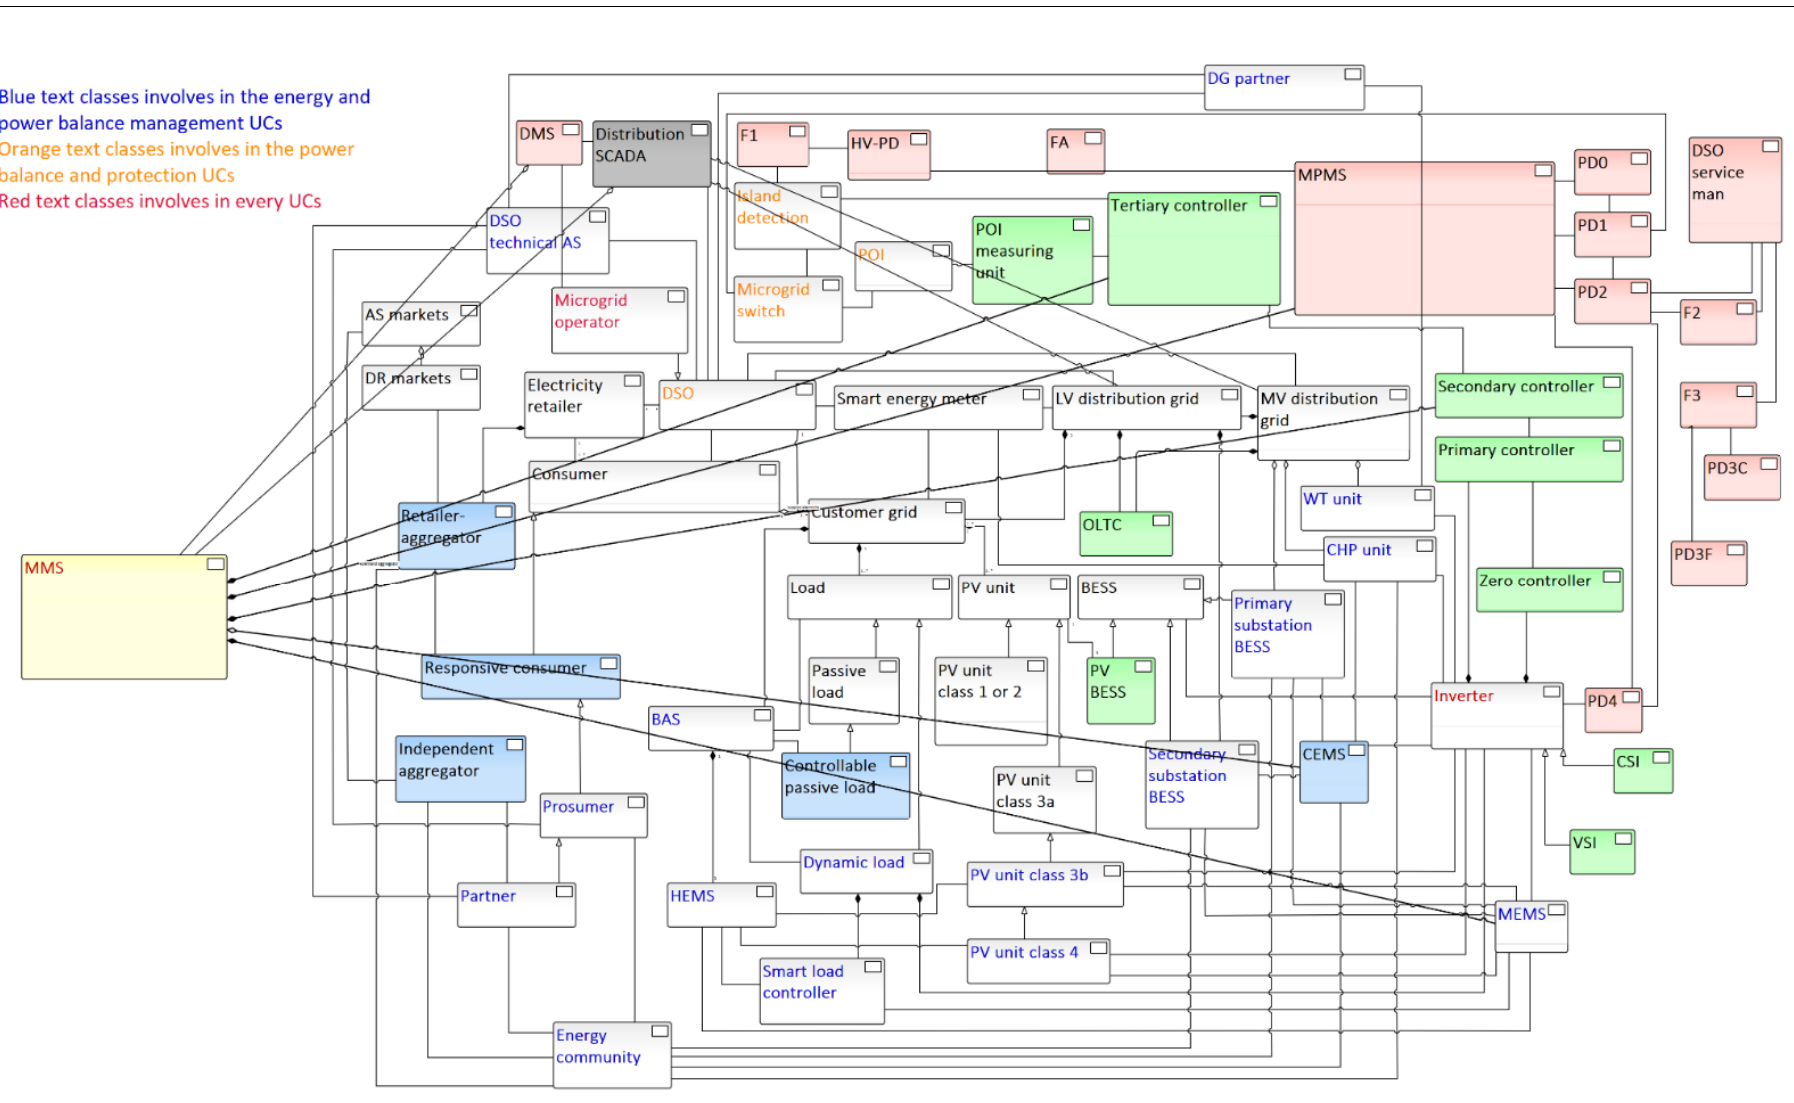
Figure 6. Class diagram of the suburban distribution network management of the microgrid phase. In the class diagrams, similar classes are combined in a more general class by gener- alization, identifying common elements of entities. Therefore, a superclass (a parent) has the most general attributes ( − ), operations (+), and relationships that can be shared with/inherits to subclasses (children). Hence, a subclass may have more specialized attrib- utes and operations. Different types of relationships between the actors are present. Ag- gregation ( ◊ ) implies a relationship where a subclass can exist independently of the super- class. Composition ( ♦ ) implies a relationship where a subclass cannot exist independent of the superclass [105]. By examining Figure 6, the study case of the microgrid phase of the Sundom smart grid, the following can be concluded. The consumer, load, PV unit, BESS, and inverter superclass have several subclasses. The MMS consists of MEMS, PMS, tertiary control- ler(s), and secondary controller(s), and it is aggregated with the DMS and SCADA. Table 8. Classified actors of the evolving electricity distribution networks. M